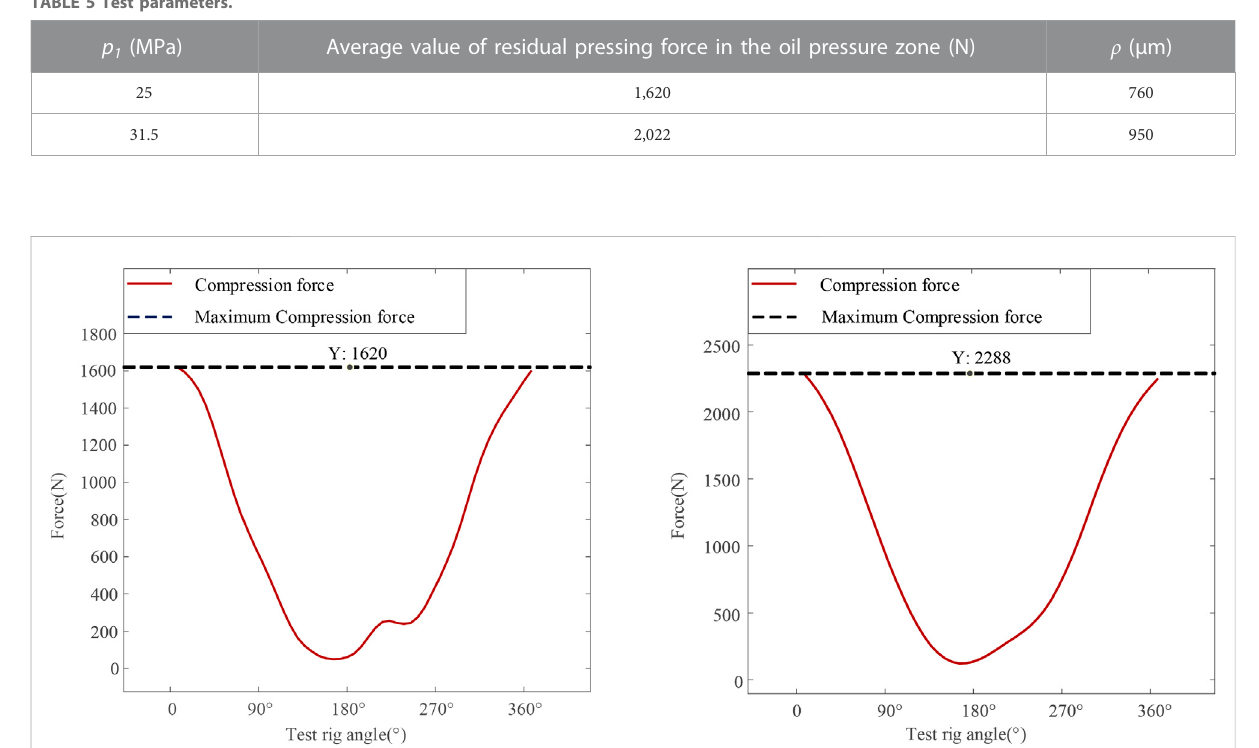
Figure 12. Under different simulated pressures, the variation trend of the real pump residual pressing force is the same as that of the simulated compression force, which can be well fi tted.